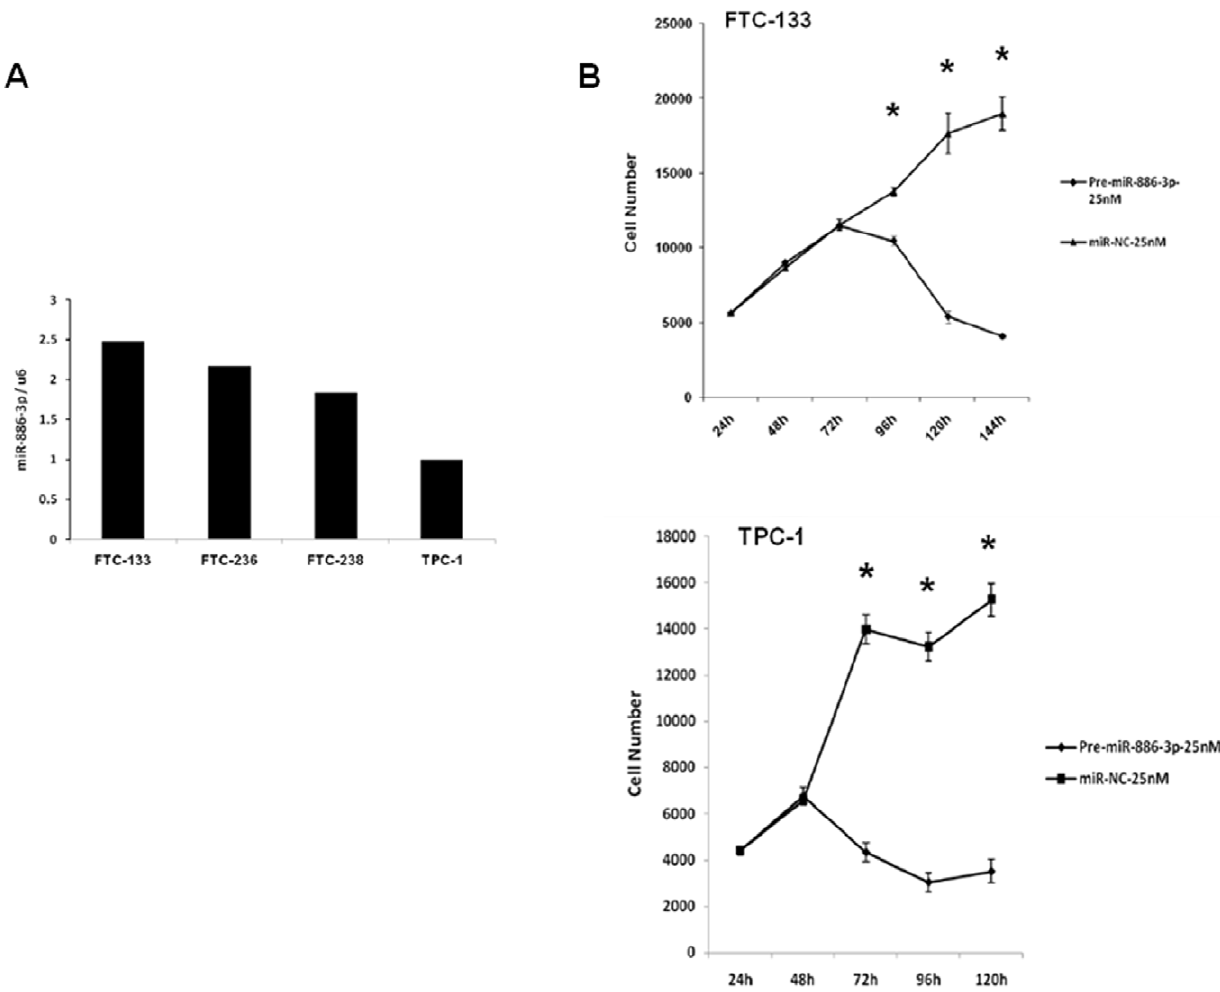
Figure 7. MiR-886-3p expression levels and function in thyroid cancer cell lines. A ) Baseline expression of miR-886-3p in four thyroid cancer lines. B ) Effect of miR-886-3p overexpression on thyroid cancer cell proliferation. Pre-miR-886-3p significantly inhibited thyroid cancer cell proliferation. Error bars represent standard error of mean. *p # 0.001.